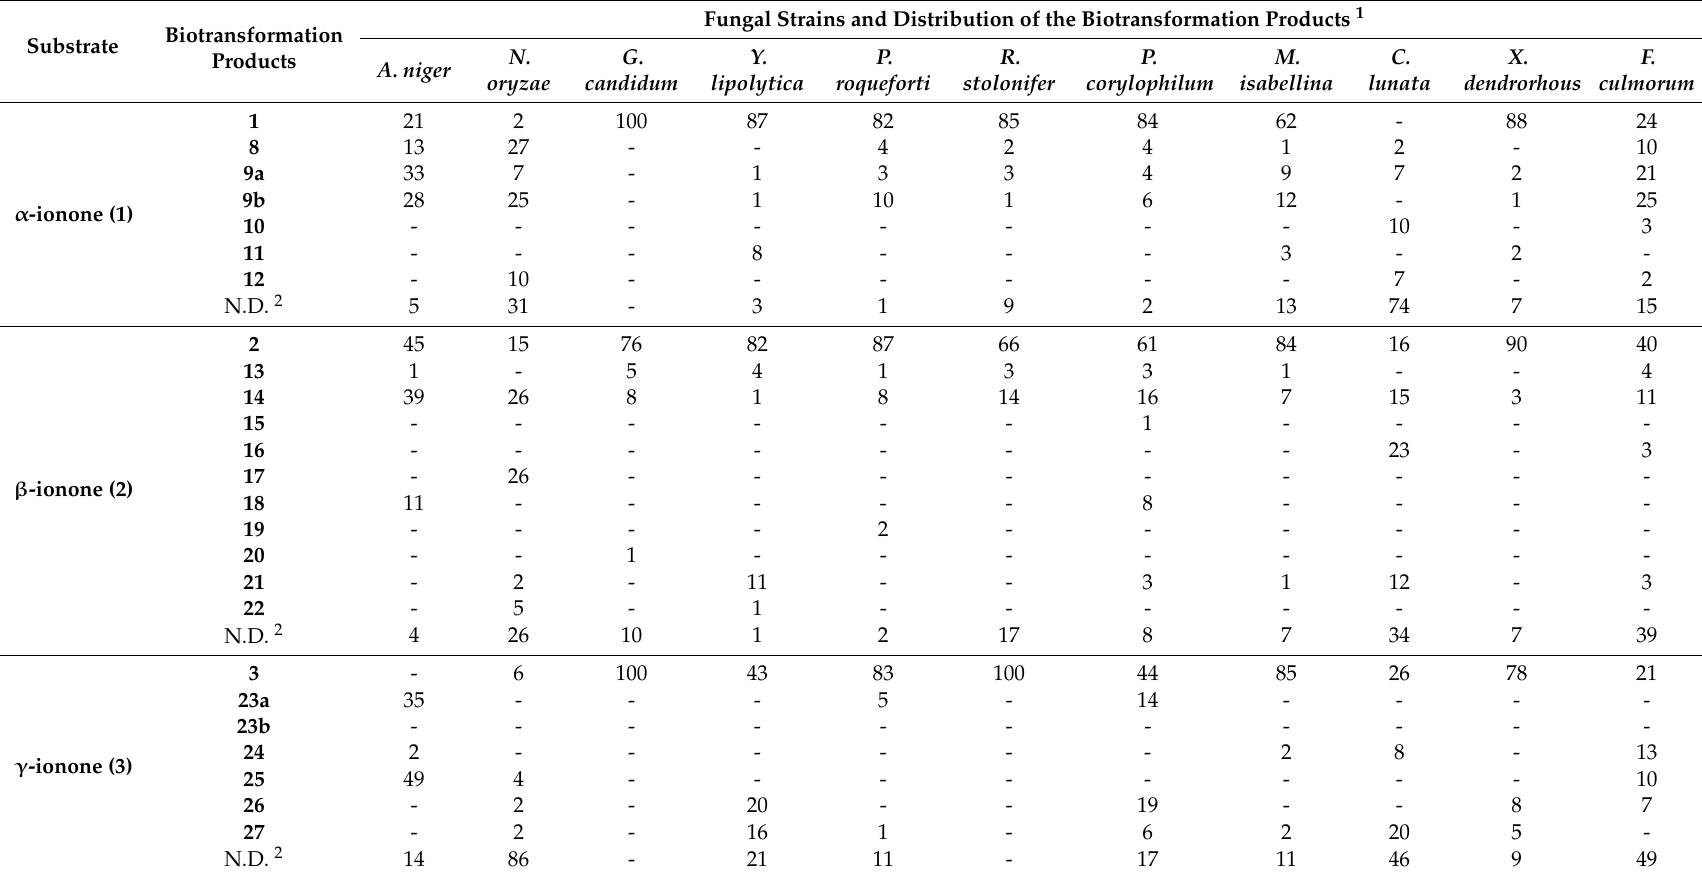
Table 1. Results of the fungi-mediated biotransformation of α -, β - and γ -ionone